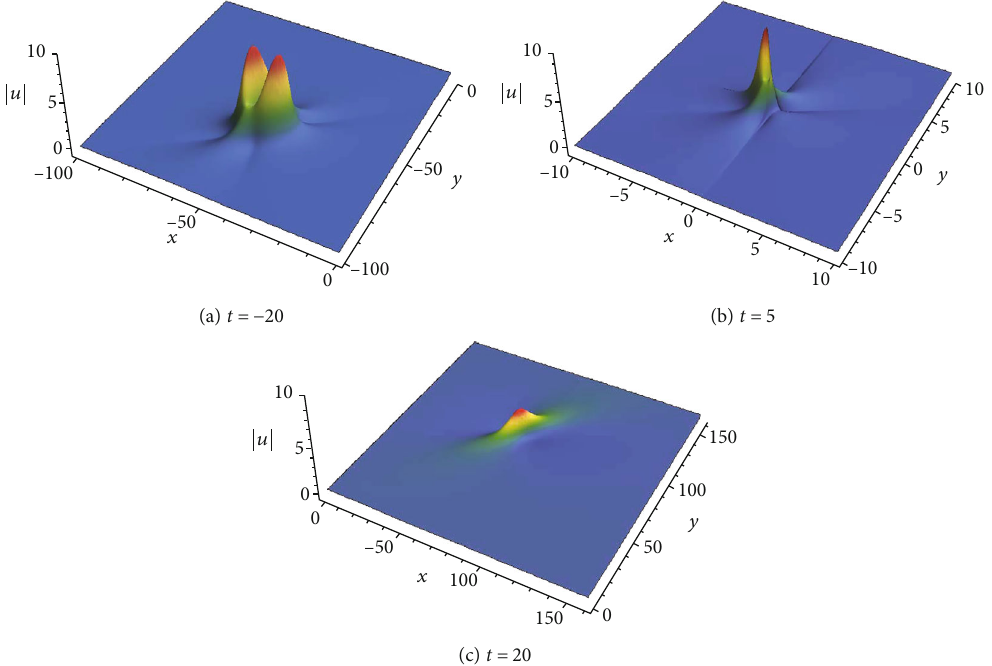
= − 0 : 6 , and a = 0 : 8 . 2 6